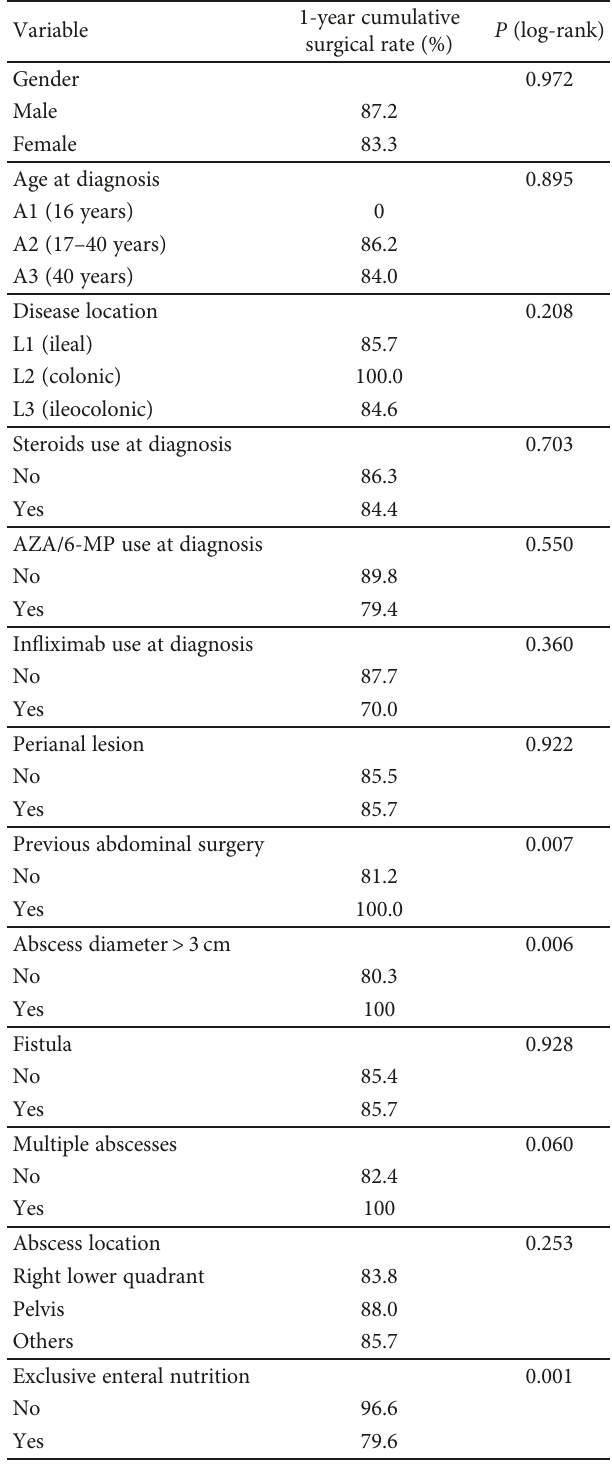
Table 2: Univariate analysis of potential predictors for surgery in CD patients with percutaneously undrainable abscesses.